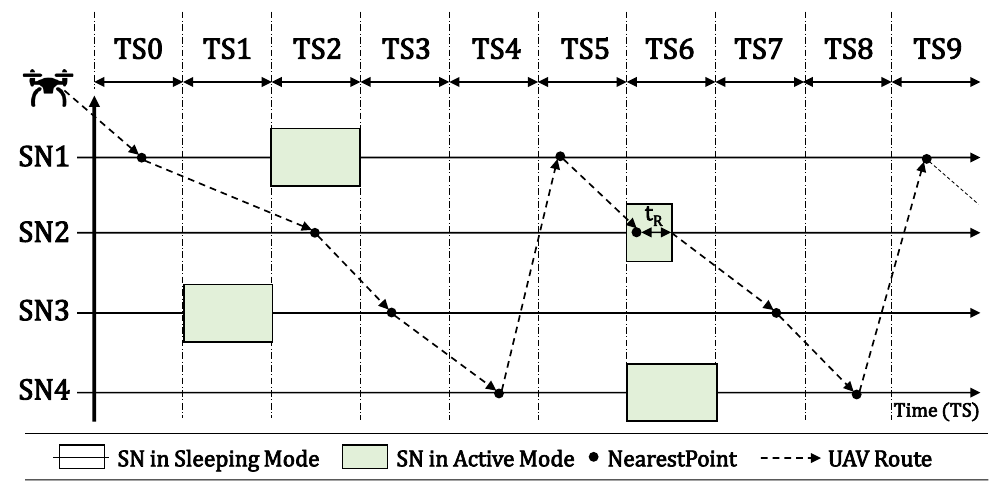
Figure 5. Shared Timeslots scenario.